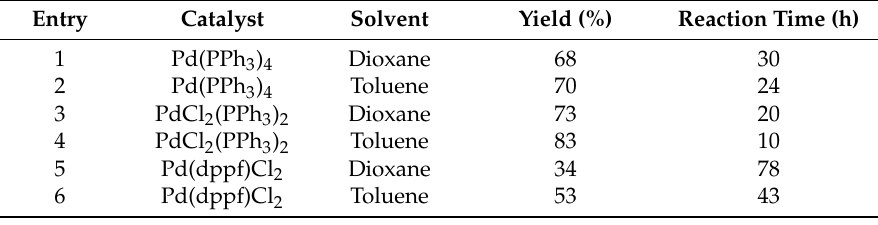
Figure 3. Key rotating frame nuclear Overhauser effect spectroscopy (ROESY) correlations of compound 21 . Table 2. Optimization of reaction condition for Stille coupling of compound 21 .